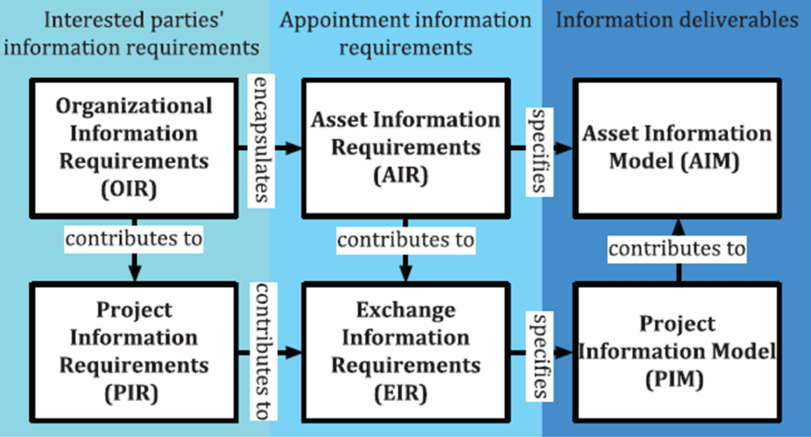
Figure 3. Hierarchy of information requirements (source: ISO